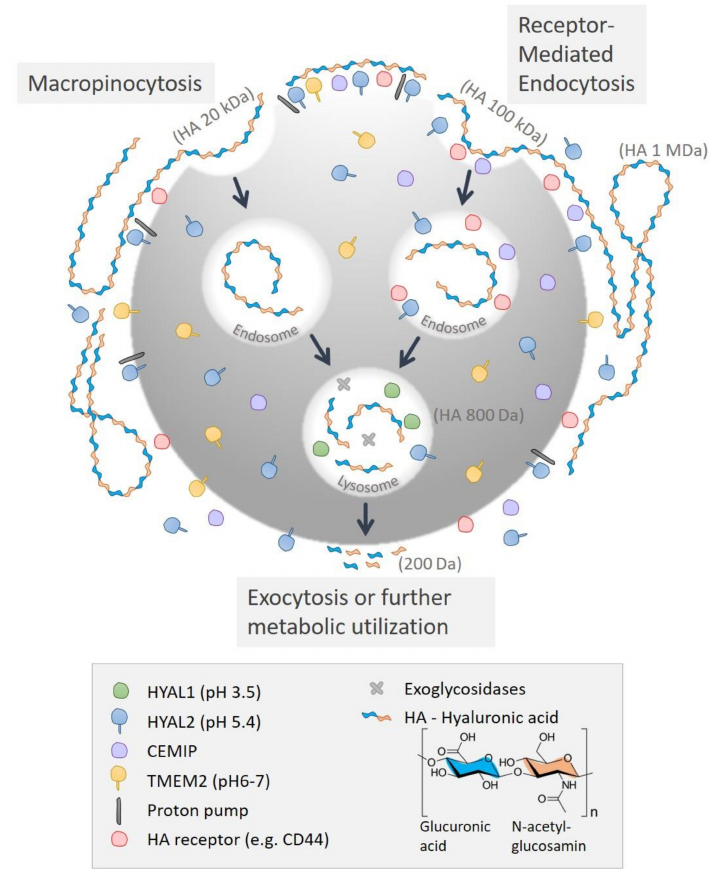
Figure 5. A suggested metabolic scheme of the degradation of hyaluronan and the localization of HA-degrading proteins in human skin. HMW HA is hydrolyzed by HYALs. This most probably initially occurs on the plasma membrane via HYAL2. The HA is then internalized into the cell via the use of surface HA scavenger receptors, CEMIP or a binding protein (e.g., CD44) for receptor-mediated endocytosis or macropinocytosis. Once internalized, the HA is degraded by HYAL1, HYAL2 and exoglycosidases in the lysosomes into small fragments and subsequently exocytosed. Modified from Csoka et al. (2001) [53] and Racine and Mummert (2012) [54]. According to our data, this mechanism is thought to occur mainly within dermal fibroblasts and basal keratinocytes. The upper keratinocytes appeared to lack the expression of CEMIP. Abbreviations: Hyaluronidase (HYAL), Transmembrane Protein type II (TMEM2), Cell Migration Inducing Hyaluronan Binding Protein (CEMIP), Cluster of differentiation 44